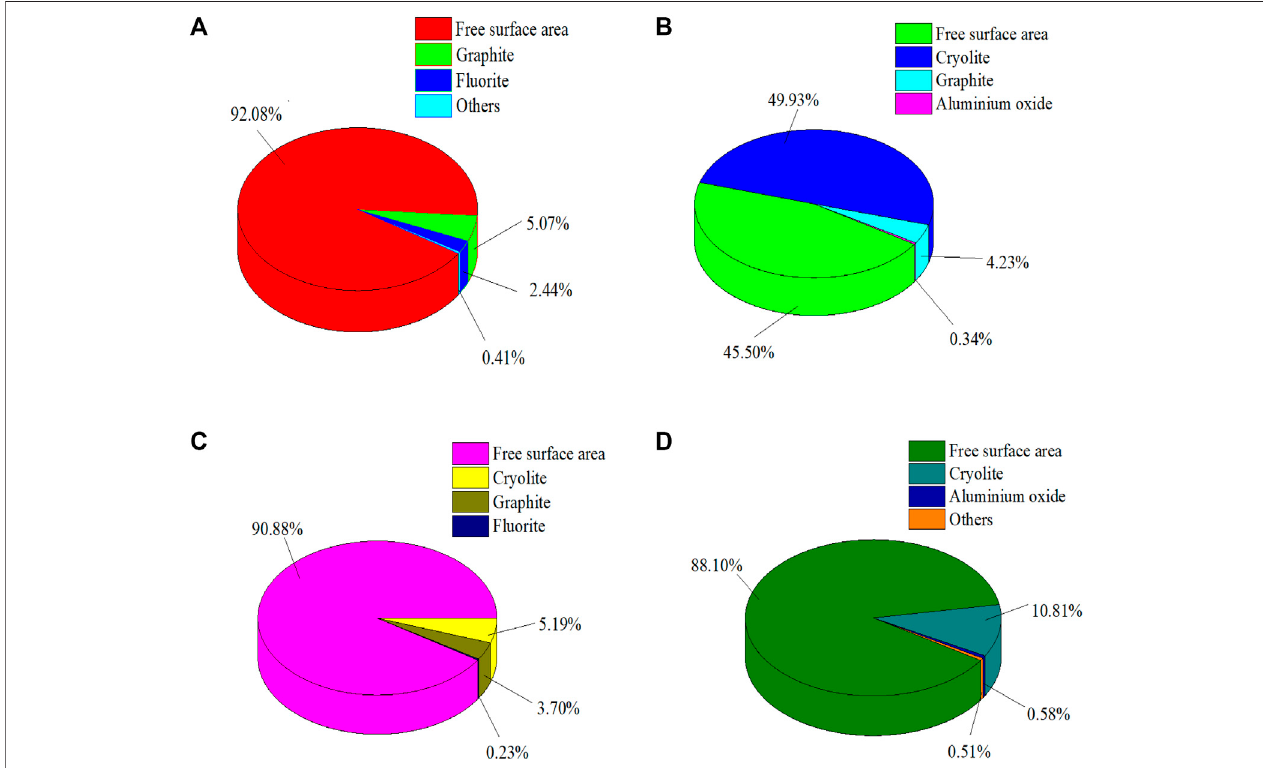
FIGURE 5 | The symbiotic relationships of major minerals. (A) The symbiotic relationship between cryolite and other minerals. (B) Symbiotic relationship between fl uorite and other minerals. (C) The symbiotic relationship between aluminum trioxide and other minerals. (D) The symbiotic relationship between graphite and other minerals.